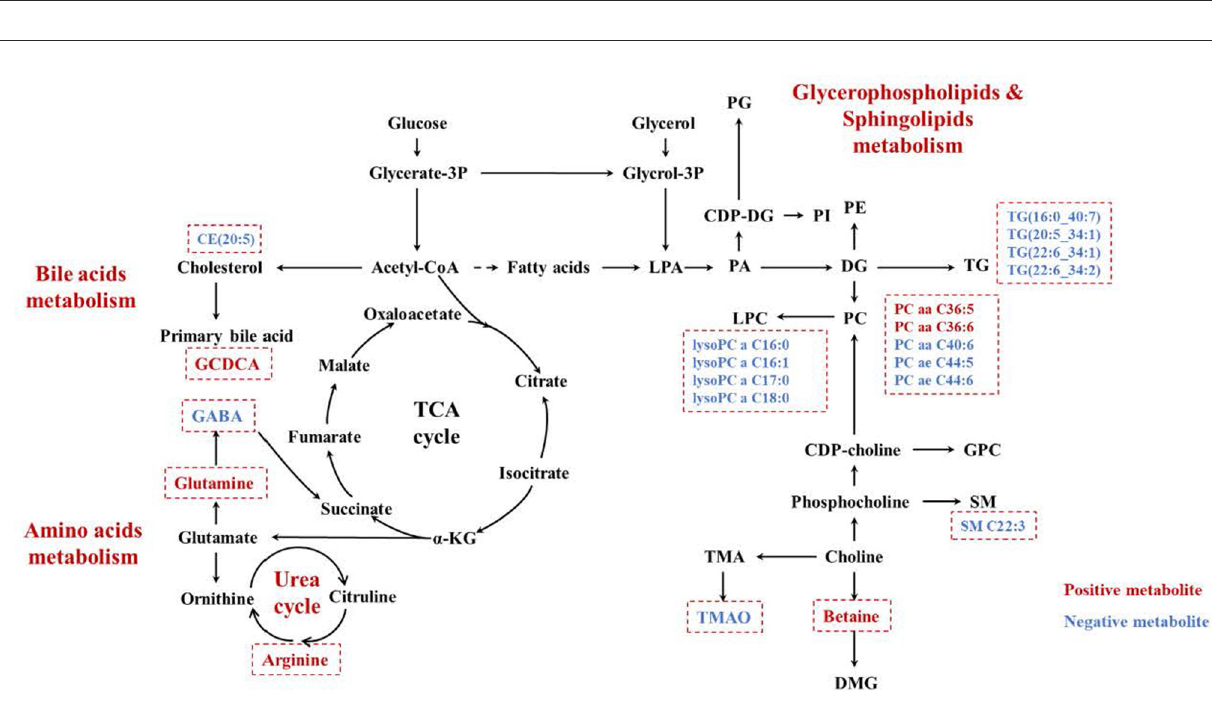
groups, most metabolites have certain statistical significance. This means that air pollution exposure had a certain impact on ever smoker and never smoker. To further investigate the effects of molecular pathways underlying PM 2.5 exposure and AECOPD,